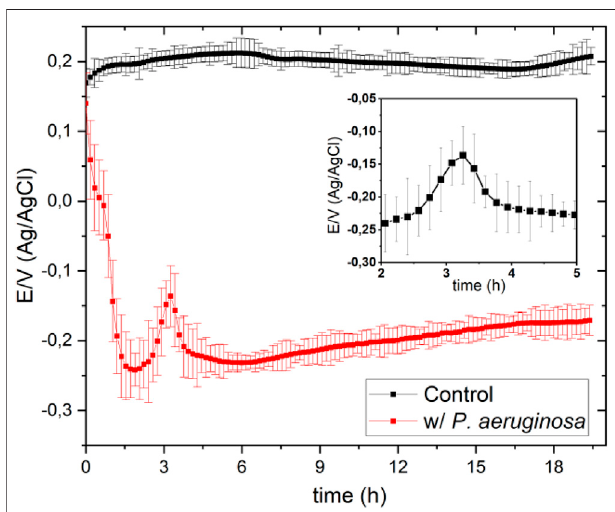
FIGURE 1 | Open circuit potentials obtained in the absence (Control/ black line) and presence (red line) of P. aeruginosa in 100 ml of Mueller-Hinton broth at pH 7 in a solution previously saturated with O 2